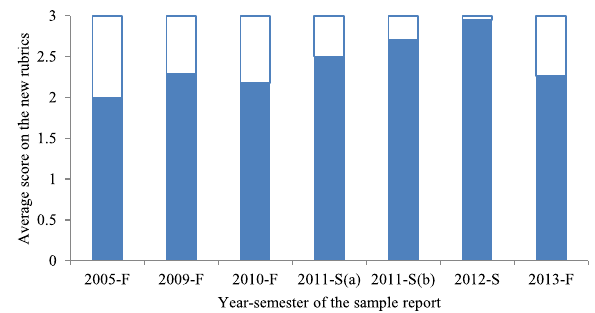
FIG. 3. Accepted old reports scored with the new rubrics. The figure shows the average score over all subabilities of each